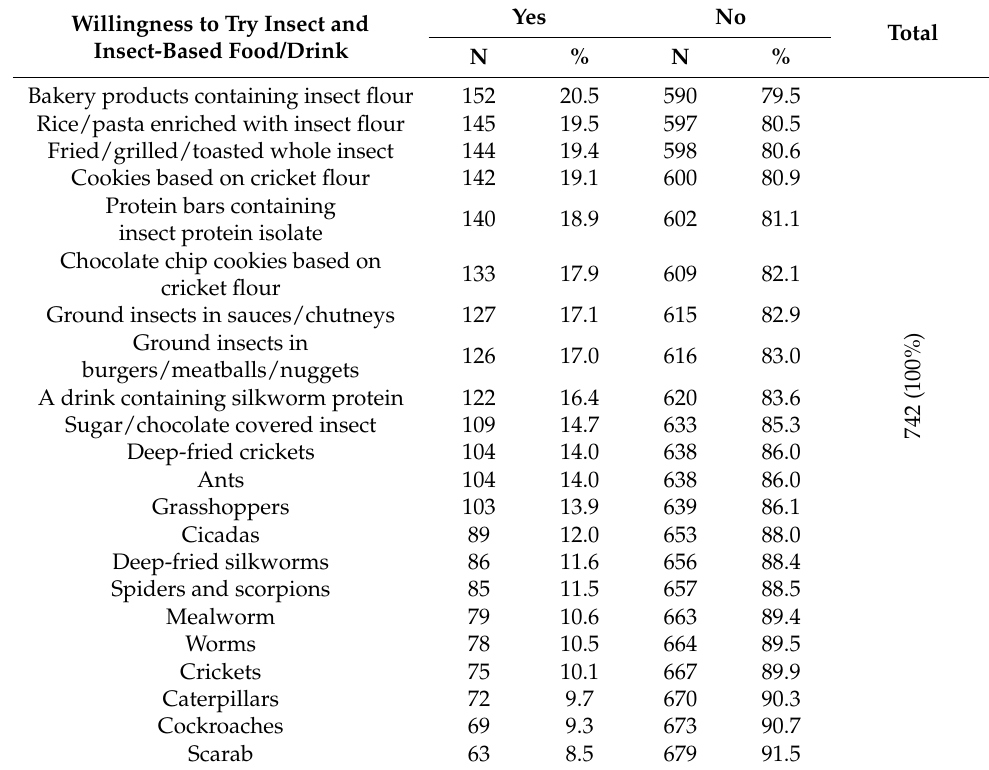
Table 3. Willingness to try insect and insect-based